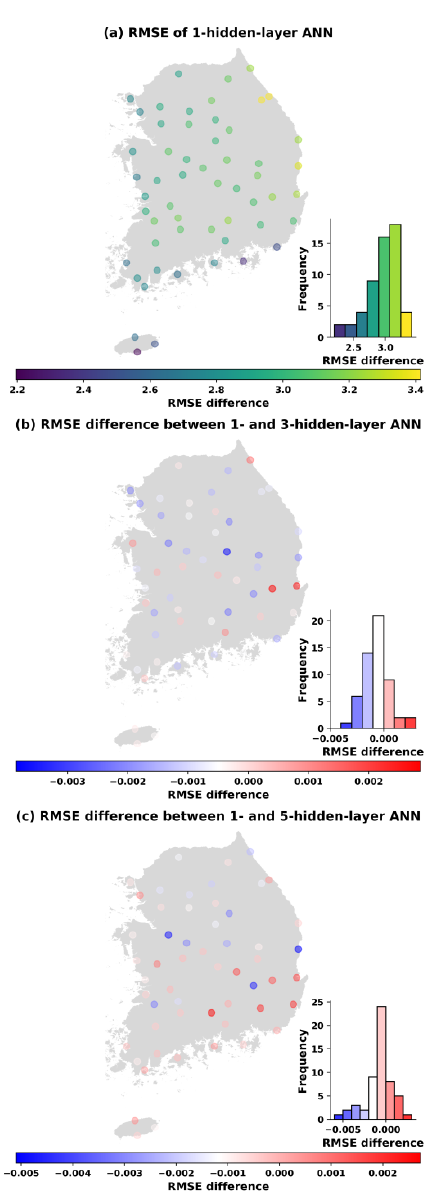
Figure 7. Panel ( a ) shows the RMSE of the test data of the 1-hidden layer model with 113 parameters; panel ( b ) shows the difference of the RMSE between the 1-hidden layer and the 3-hidden layer model (RMSE difference <0 indicates that the 1-hidden layer model performs better than the 3-hidden layer model and vice versa); and panel ( c ) shows the RMSE difference between the 1-hidden layer and the 5-hidden layer model (RMSE difference <0 indicates that the 1-hidden layer model performs better, RMSE difference >0 shows the opposite).